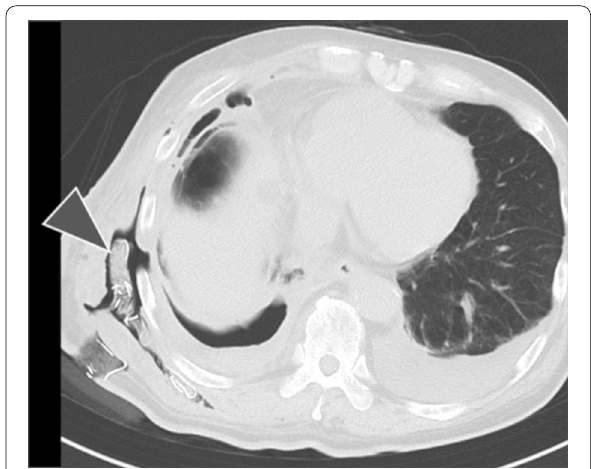
Fig. 3 CT scan demonstrating bilateral pleural effusion and abscess cavity extending below the serratus anterior muscle. CT: computed tomography; Black triangle: abscess